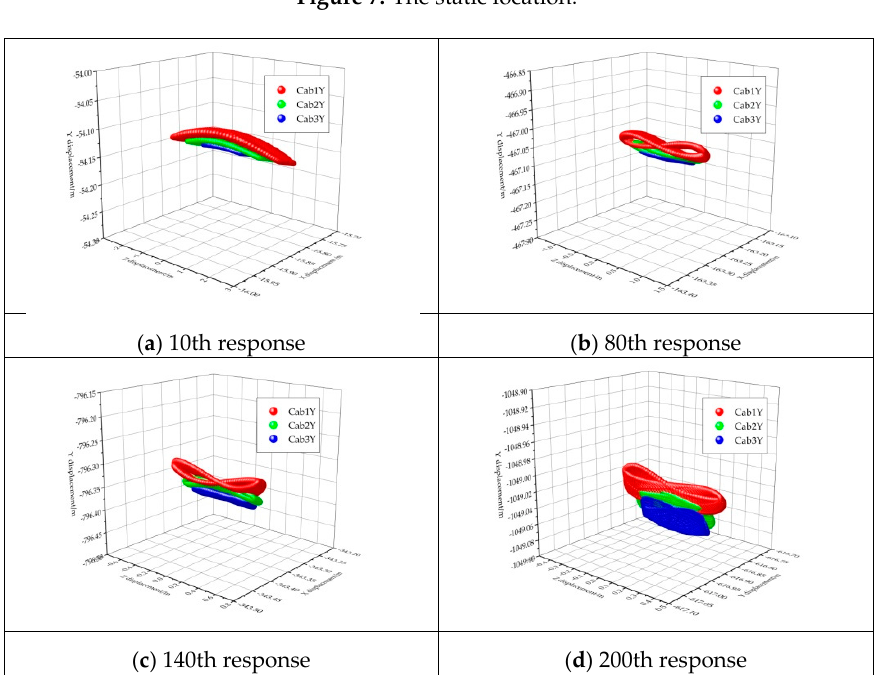
Figure 8. 10th – 200th three dimensional response of no rigid body swing.